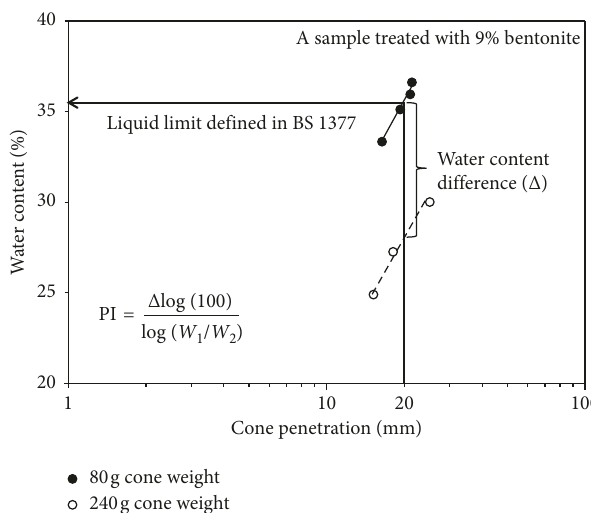
Figure 1: An example of using fall cone test results to determine LL and